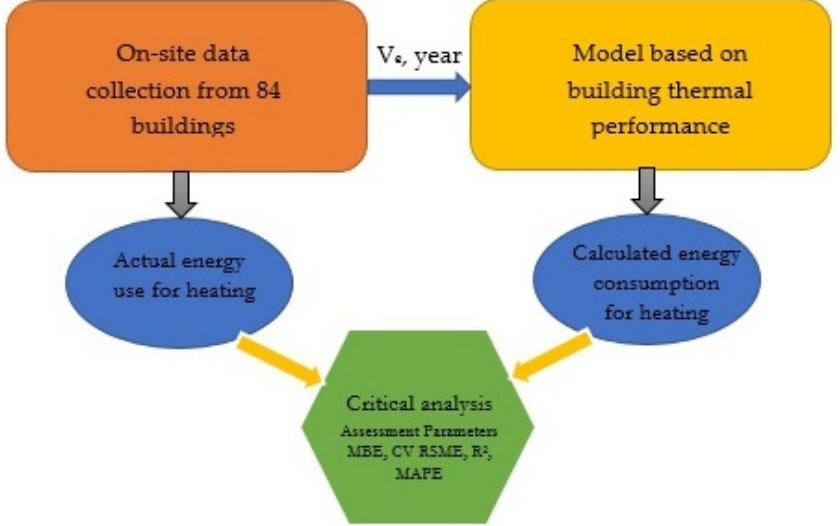
Figure 3. Methodological scheme of the performed activities.